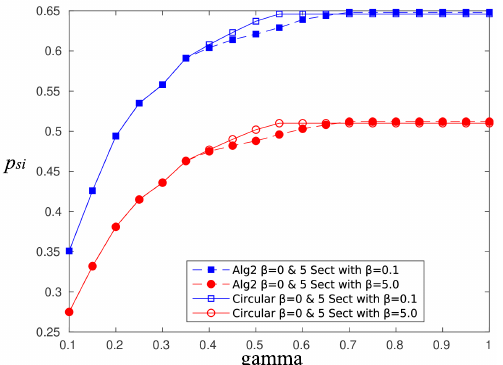
Figure 16. Probability of successful information reception, p si , Algorithm 2 vs. circular selection of sectors.